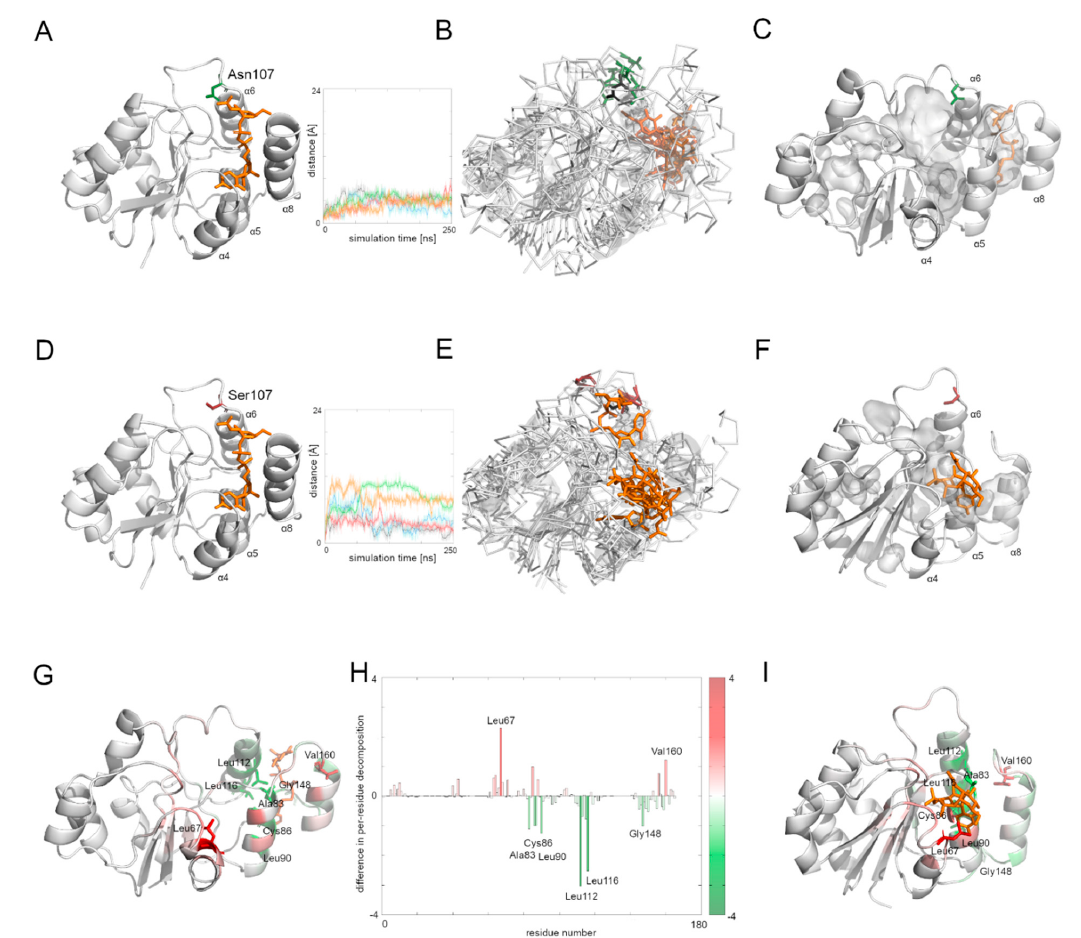
Figure 5. Different interactions with the UDP-GlcNAc substrate of the native Alg13 protein and its Asn107Ser variant. ( A ) Native Alg13 protein structure with substrate, ( B ) a set of five structures at the end of the simulation of the native human Alg13 with substrate, ( C ) structure in the last frame of the simulation of the native Alg13 and position of the substrate, ( D ) Asn107Ser variant of the human Alg13 protein with substrate, ( E ) a set of five structures at the end of the simulation of the Asn107Ser variant of the human Alg13 with substrate, and ( F ) structure in the last frame of the simulation of Asn107Ser variant of the human Alg13 protein and position of the substrate, ( G ) structure in the last frame of the simulation of native Alg13 and residues which interacted differently with the native protein and its Asn107Ser variant, ( H ) differences in per-residue free energy contribution in substrate binding plot, ( I ) structure in the last frame of the simulation of the Asn107Ser variant of the human Alg13 protein. The starting point structure is shown as cartoons with the 107 residue and the substrate shown as sticks. The native Asn107 is colored green, and the Asn107Ser residue is red. The substrate is shown as orange sticks. The set of five structures at the end of the simulation are shown as ribbons, and the starting point structure (transparent cartoons and black sticks for the starting position of the 107 residue) overlaps with them. Distance plots show the distance between the starting position of 107 residue’s C α atom and its position in each simulation frame; each colored line represents one simulation. For the sample structures of Alg13 with the substrate, cavities are shown using PyMOL software [45] and important secondary structures are marked. The values of the difference in per-residue free energy contribution in the substrate binding were calculated in a way that the energy values of the mutant variant were subtracted from the values of the native protein. The red bars represent regions, which were highly contributing in substrate binding in Asn107Ser variant, but were not identified for the native protein. Residues with the highest differences in per-residue contribution (higher than +1 kcal/mol and lower than − 1 kcal/mol) are shown on panels ( G – I